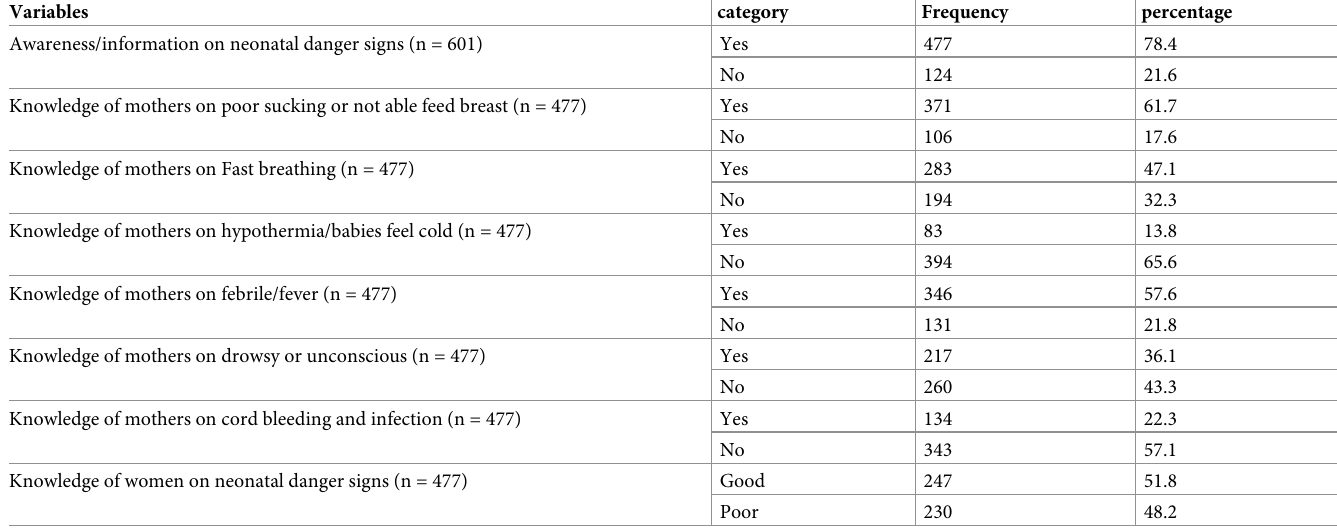
danger signs out of the 6 common danger signs and were classified as having good knowledge of neonatal danger signs (Table 4). Components of essential newborn care practice Cord care practice. The majority of respondents 443 (73.7%) cut their newborn cord with a new blade, 392 (65.2%) tied their cords with new thread, and 411 (68.4%) did nothing to their newborn cord (Table 5). Three hundred ninety-six (65.9%) of mothers had implement all essential cord care practice which were classified as good cord care practice, and 205 (34.1%) practiced poor cord care. Table 4. Knowledge status of home delivered women toward neonatal danger signs in Guto Gida district, Oromia regional state, Ethiopia, 2020.